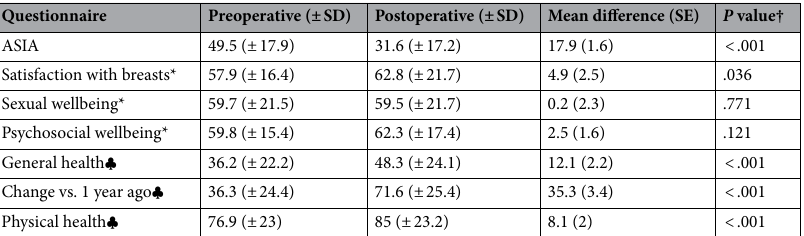
Table 5. Comparison of pre- vs. postoperative mean questionnaire (subdomain) summary scores (n = 109). † Paired samples t-test. * BREAST-Q subdomains: higher score indicates better QoL. ♣ SF-36 subdomains: higher score indicates better